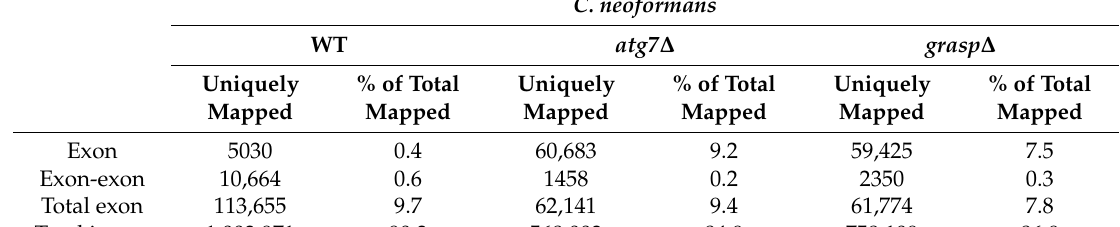
Table 1. RNA-seq mapping statistics. The values refer to the average of the replicates.